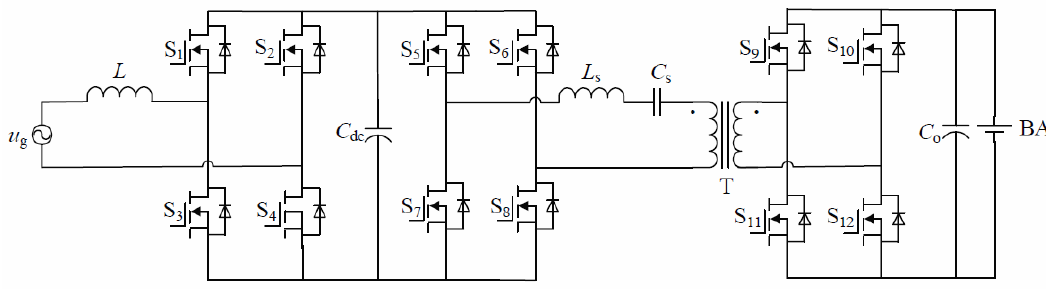
Figure 16. The two-stage topology with PWM converter and series resonance convertor.